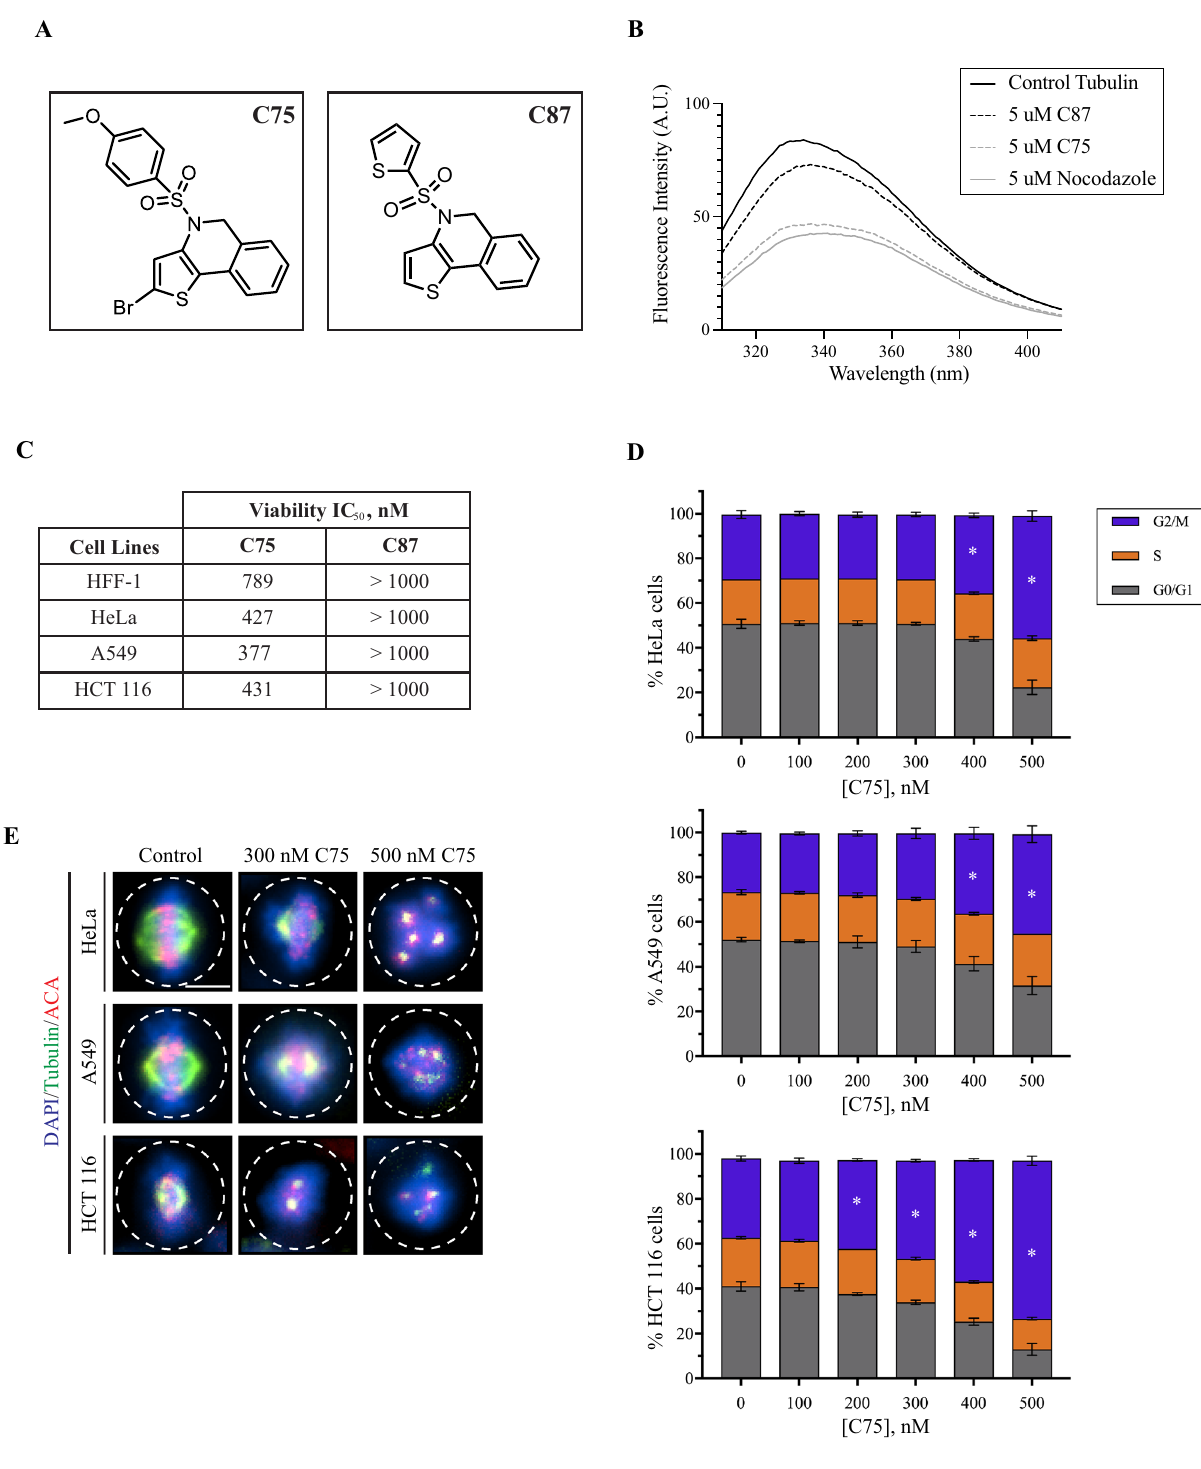
Figure 1. C75 is a thienoisoquinoline compound that causes G2/M arrest in cultured human cells. ( A ) The structures of C75 and C87, a derivative with minimal activity, are shown. ( B) A graph shows the absorbance of tubulin (control, grey line) measured by a change in fluorescence (y-axis), compared to when 5 uM of C87, C75 or nocodazole was added to tubulin for the wavelengths as shown on the x-axis. ( C) A table shows the IC 50 for the viability of HFF-1, HeLa, A549 and HCT 116 over three population doubling times after treatment with C75 or C87 (N = 3). ( D) Bar graphs show the distribution of cells in G0/G1, S and G2/M phases of the cell cycle measured by flow cytometry, for HeLa, A549 and HCT116 cells treated with increasing concentrations of C75 for 8 h (n = 20,000 cells per treatment; N = 3 experimental replicates). Asterisks indicate statistical significance using two-way ANOVA test and post-hoc Tukey’s multiple comparison test with a 95% CI, multiplicity adjusted p = < 0.0004. ( E) Images show fixed HeLa, A549 and HCT116 cells immunostained for DNA (DAPI; blue), tubulin (green), and centromeres (ACA; red) after treatment with 300 or 500 nM of C75 for 8 h. Dotted lines outline the cells. The scale bar is 10